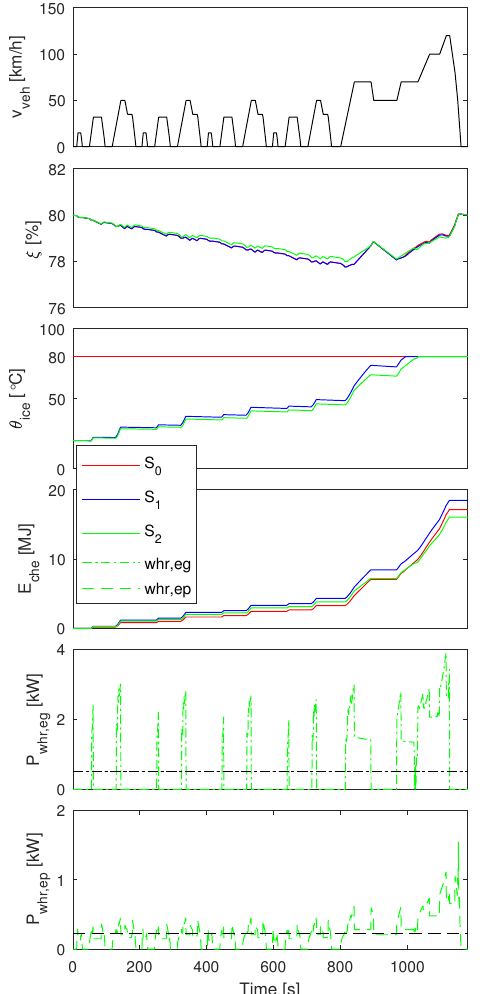
Figure 2. Integrated energy and thermal management for the New European Driving Cycle using three simulation settings. ( Top to bottom ) Vehicle velocity ( v veh ), state of charge of the battery ( ξ ), engine temperature ( θ ice ), chemical energy ( E che ), recovered power from the exhaust gases P whr , eg , and recuperated power from the electric path P whr , ep